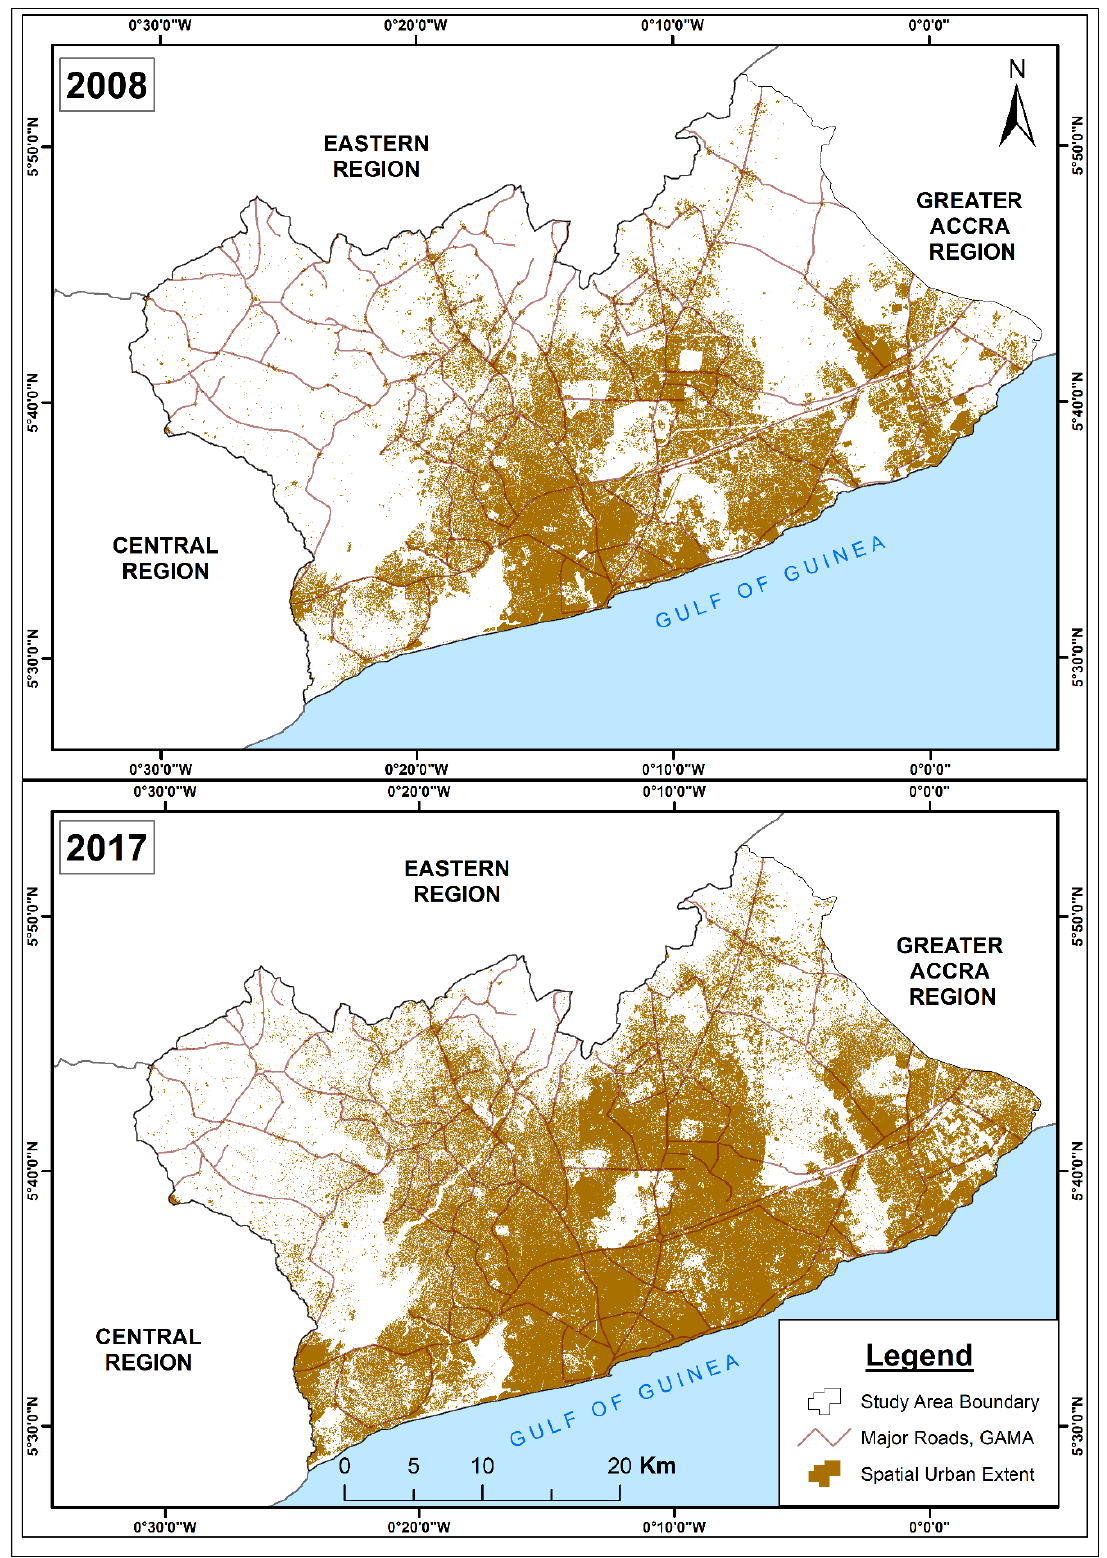
Figure 4. Spatial extent of urban built-up in GAMA in 2008 and 2017.